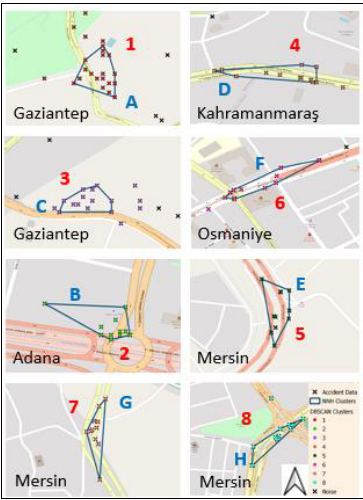
Figure 7. Mersin Region Speed-related Accident Clusters Map of 2020-2021 (NNH and DBSCAN are overlaid)